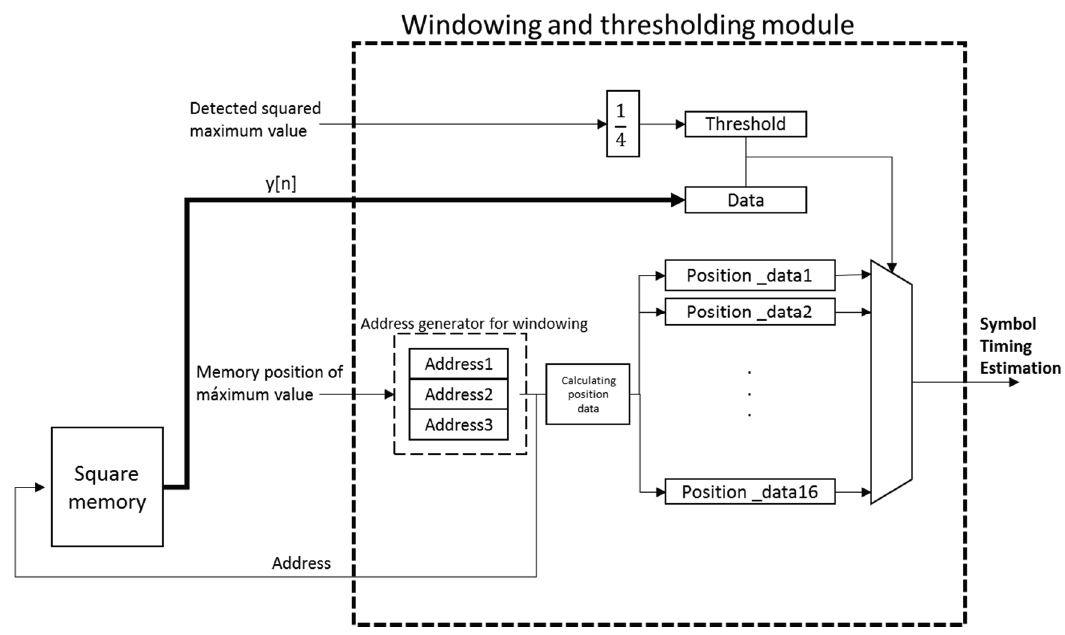
Figure 9. Block diagram of the proposed windowing and thresholding module.